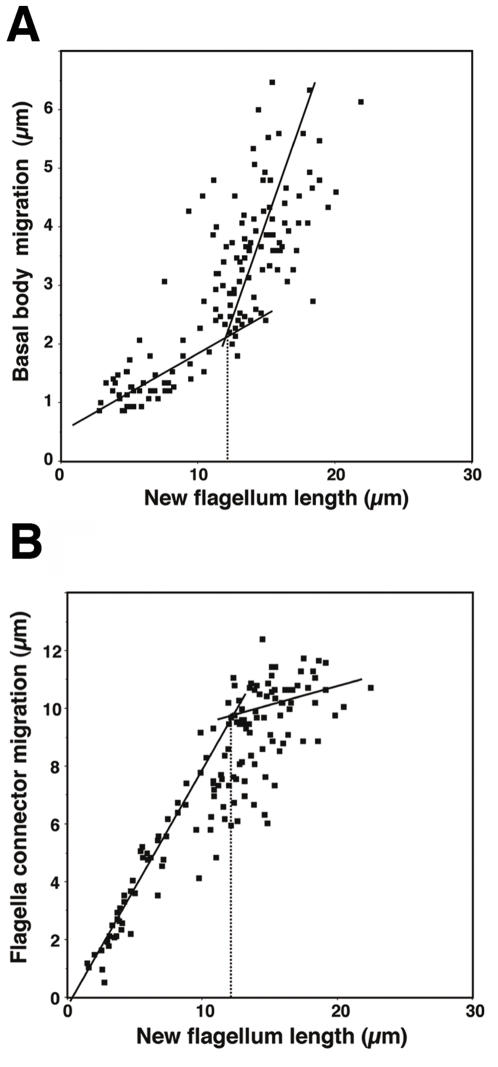
FC migration along the old flagellum is bimodal.A–B. New flagellum length, inter basal body distance and position of the FC on the old flagellum were measured in bi-flagellated wild-type cells at any stage of flagellum assembly.